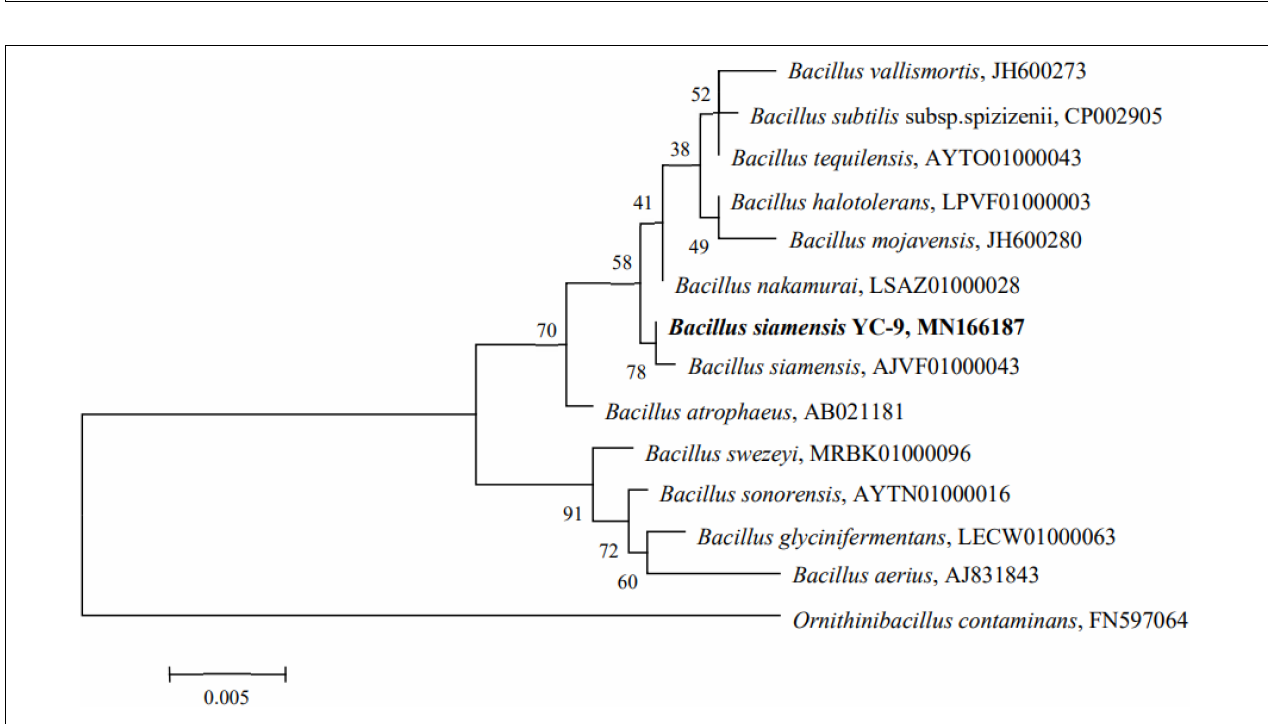
FIGURE 3 | Phylogenetic tree of strain YC-9 based on maximum-likelihood method analysis of 16S rRNA sequences data.